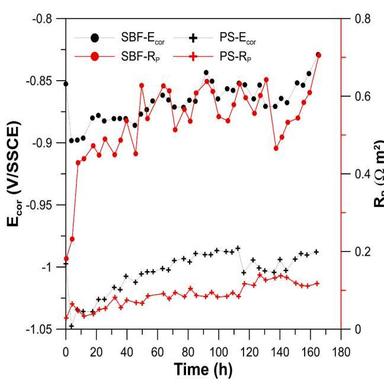
The Rp and Ecor values during the one-week exposure in physiological saline solution (PS) and SBF solution at 37 ◦C.